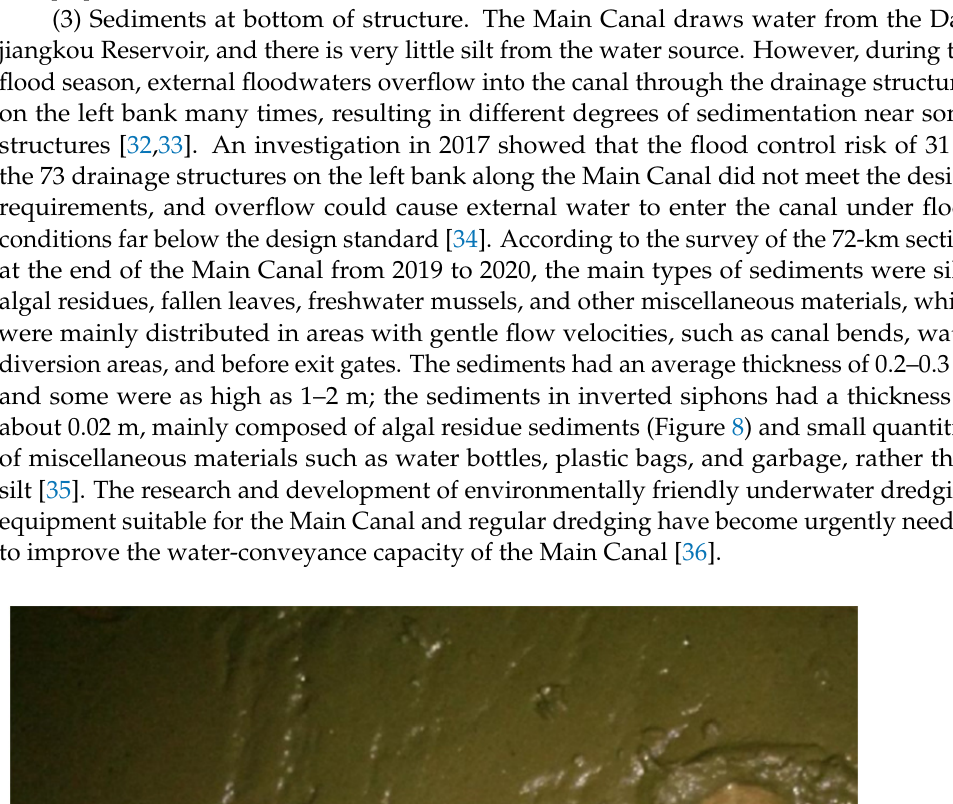
( b ) Figure 9. Flow regime at the outlet: ( a ) the aqueduct of the tributary of the Shuangji River and ( b ) the aqueduct of the Lihe River.